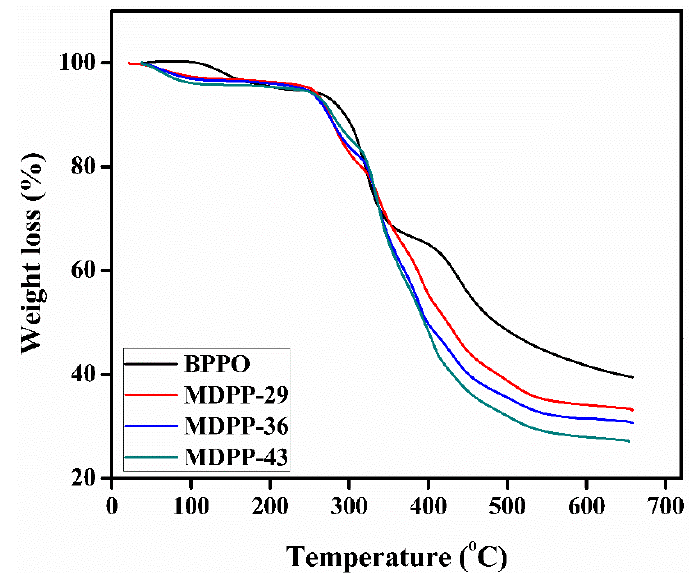
Figure 3. TGA thermograms for different membranes MDPP-0 to MDPP-43.